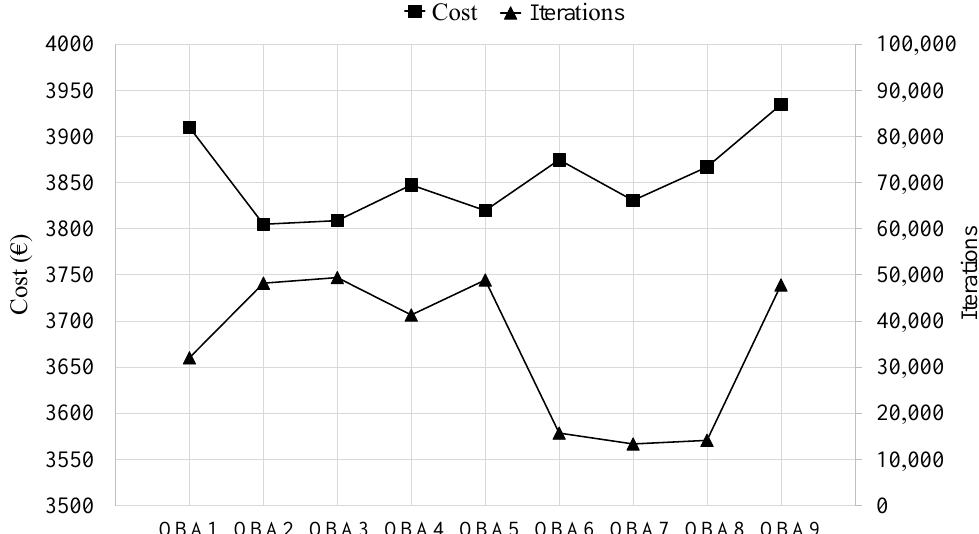
Figure 10. Minimum final cost and associated computational cost for each of the OBA algorithm